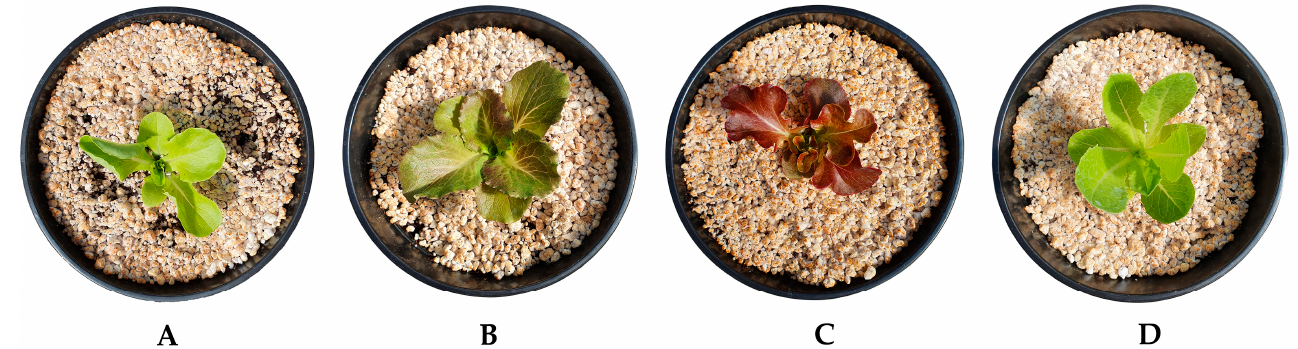
Figure 5. Illustrative picture of Lactuca sativa L. genotypes used in the experiment at transplant. ‘Ballerina’ ( A ), ‘Canasta’ ( B ), ‘Oak leaf’ ( C ), and ‘Romaine’ ( D ).